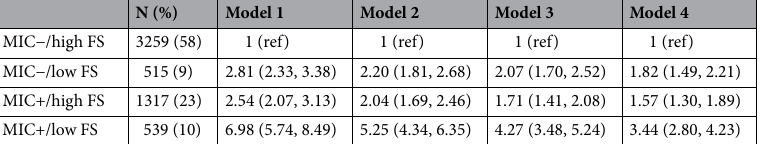
Table 4. Association of MIC and FS status combinations on risk of death, by level of adjustment. Crude death rate was 8.9 per 100 patient-years (N = 869 deaths). The association of MIC and FS status with risk of death was evaluated using Cox proportional hazards models adjusted for baseline characteristics. The models were defined by the covariates added to the model, as follows: Model 1 : stratified by country and phase of the study. Model 2 : Adjusted for age, sex, and body mass index. Model 3 : Model 2 adjustments, plus comorbidity history, and catheter use. Model 4 : Model 3 adjustments, plus serum creatinine and phosphorus levels, WBC count, hemoglobin level, and vintage (main model). Values are hazard ratios (95% confidence interval). MIC, malnutrition-inflammation-complex; FS, functional status.